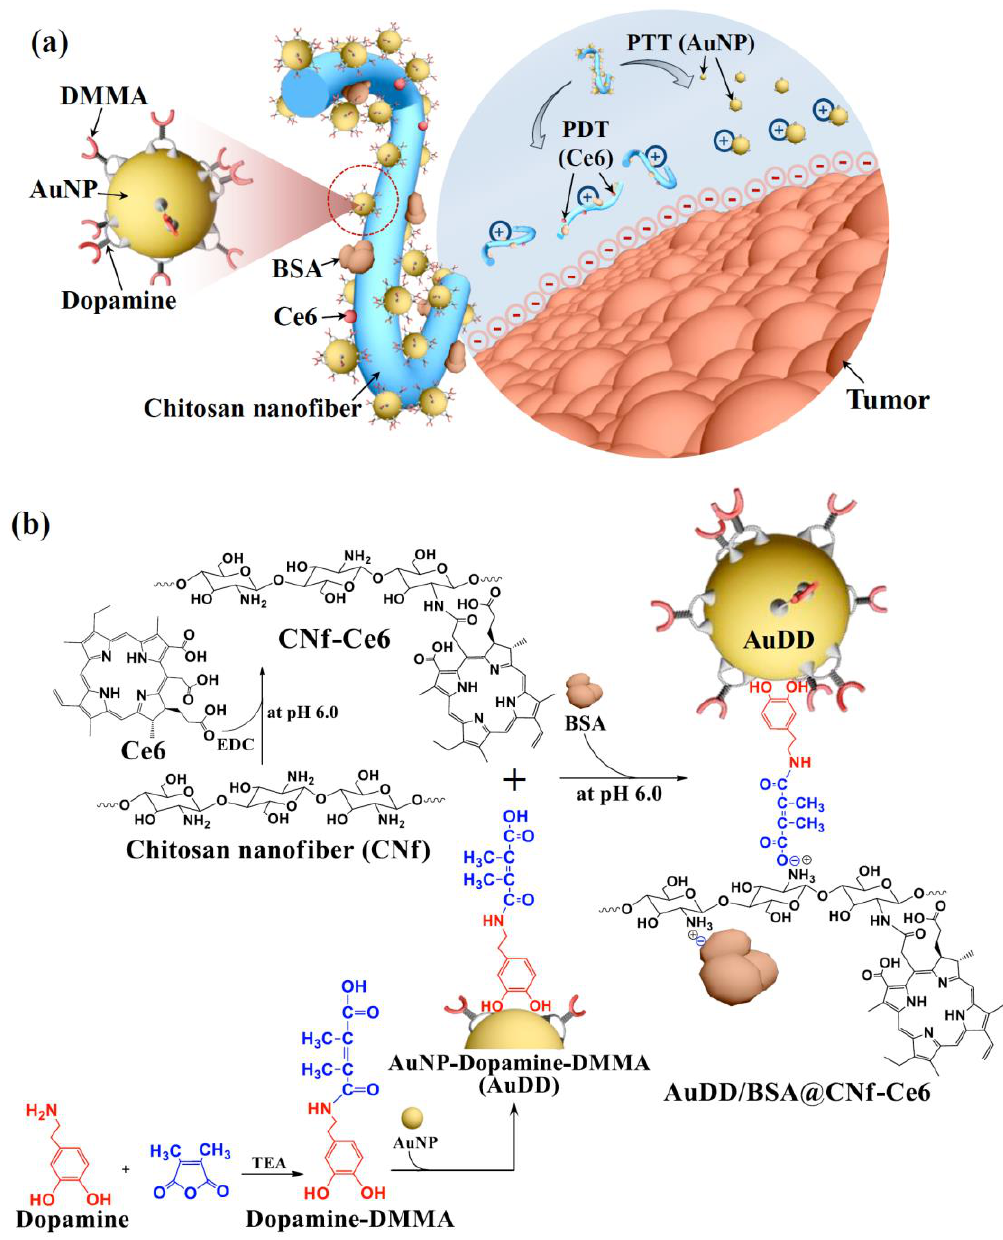
Figure 1. ( a ) Schematic concept for the integration of pH e -sensitive chitosan nanofiber with AuNP, Ce6, and BSA. ( b ) Scheme for the synthesis of